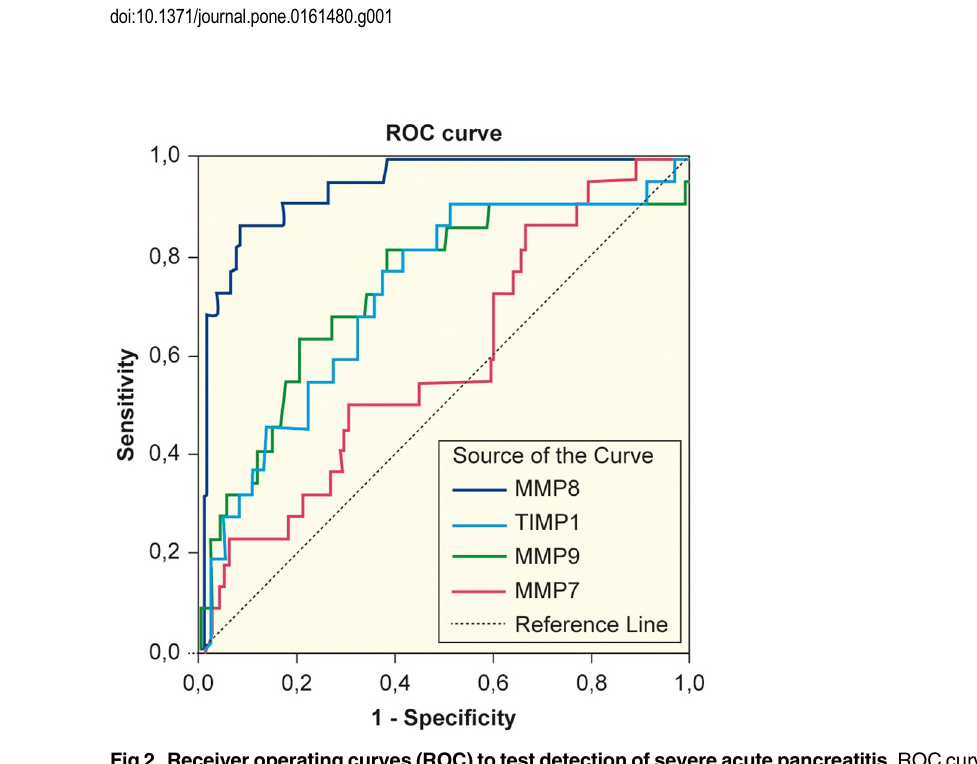
Fig 2. Receiver operating curves (ROC) to test detection of severe acute pancreatitis. ROC curves demonstrating the ability of MMP-7, MMP-8, MMP-9 and TIMP-1 to detect severe acute pancreatitis. MMP; matrix metalloproteinase. TIMP; tissue inhibitor of matrix